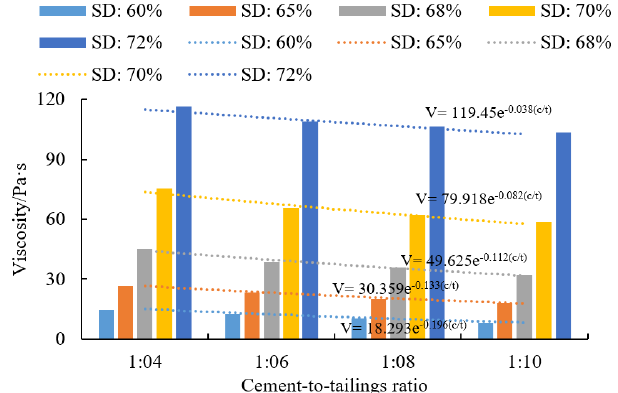
Figure 6. Histogram between c/t and viscosity of CTB samples.